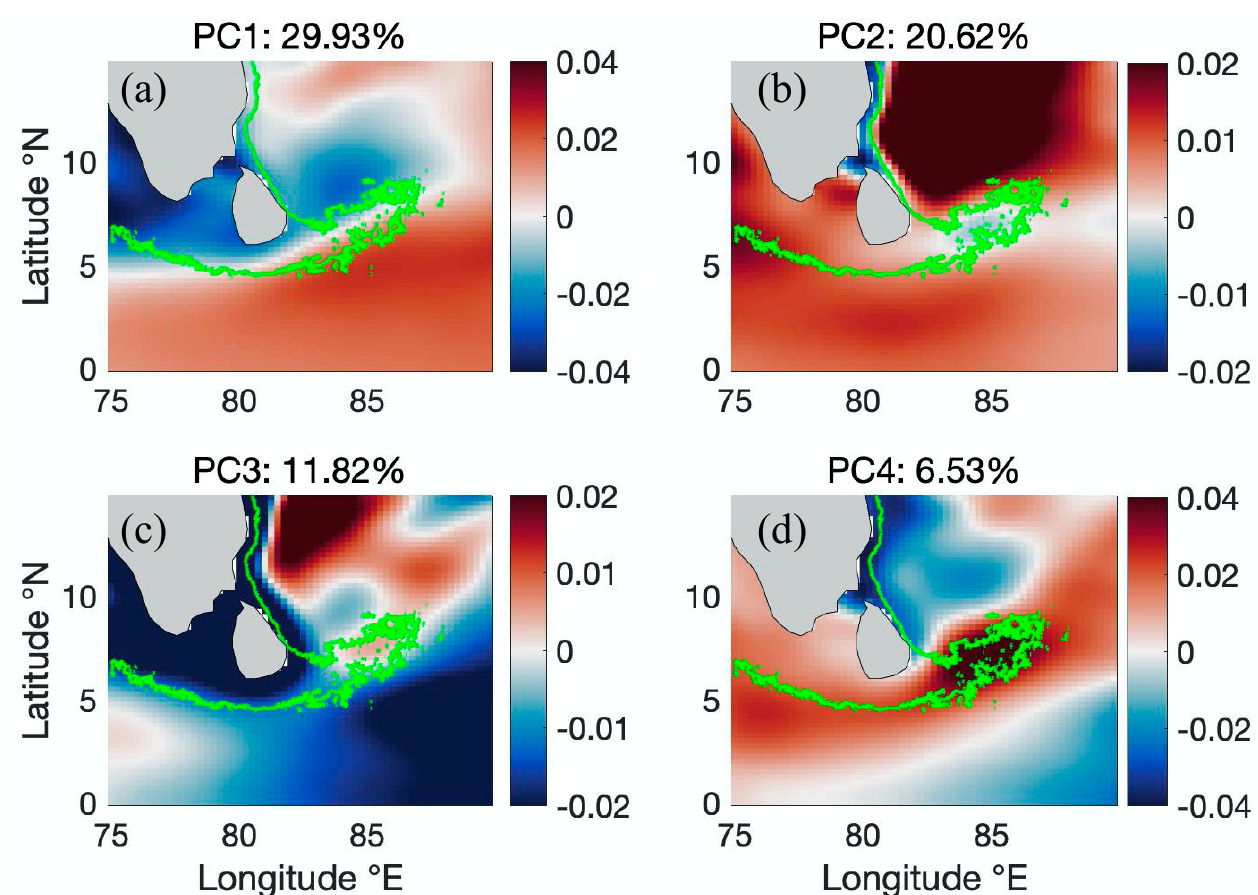
Figure 6. Principal components (PCs) of the first four leading EOF modes ( a – d ) for monthly mean SSHA detrend . Lower panels show the timeseries of the four modes. Contours in upper panels denote the chlorophyll concentration of 0.35 mg m − 3 in Figure 2b.